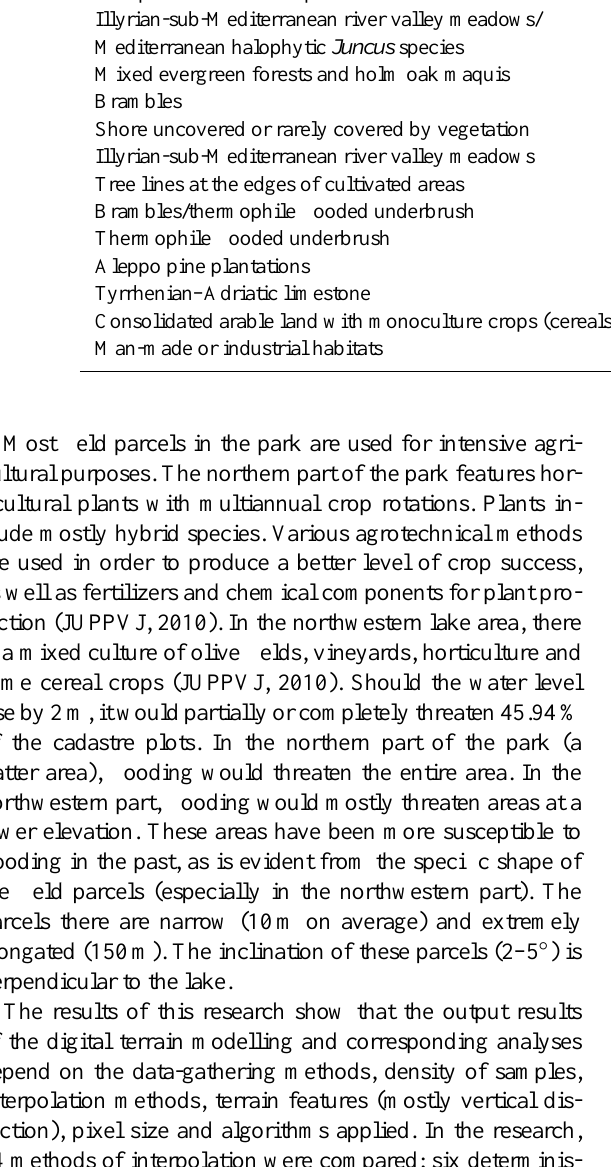
(ha) habitat in the NP (ha) (%)